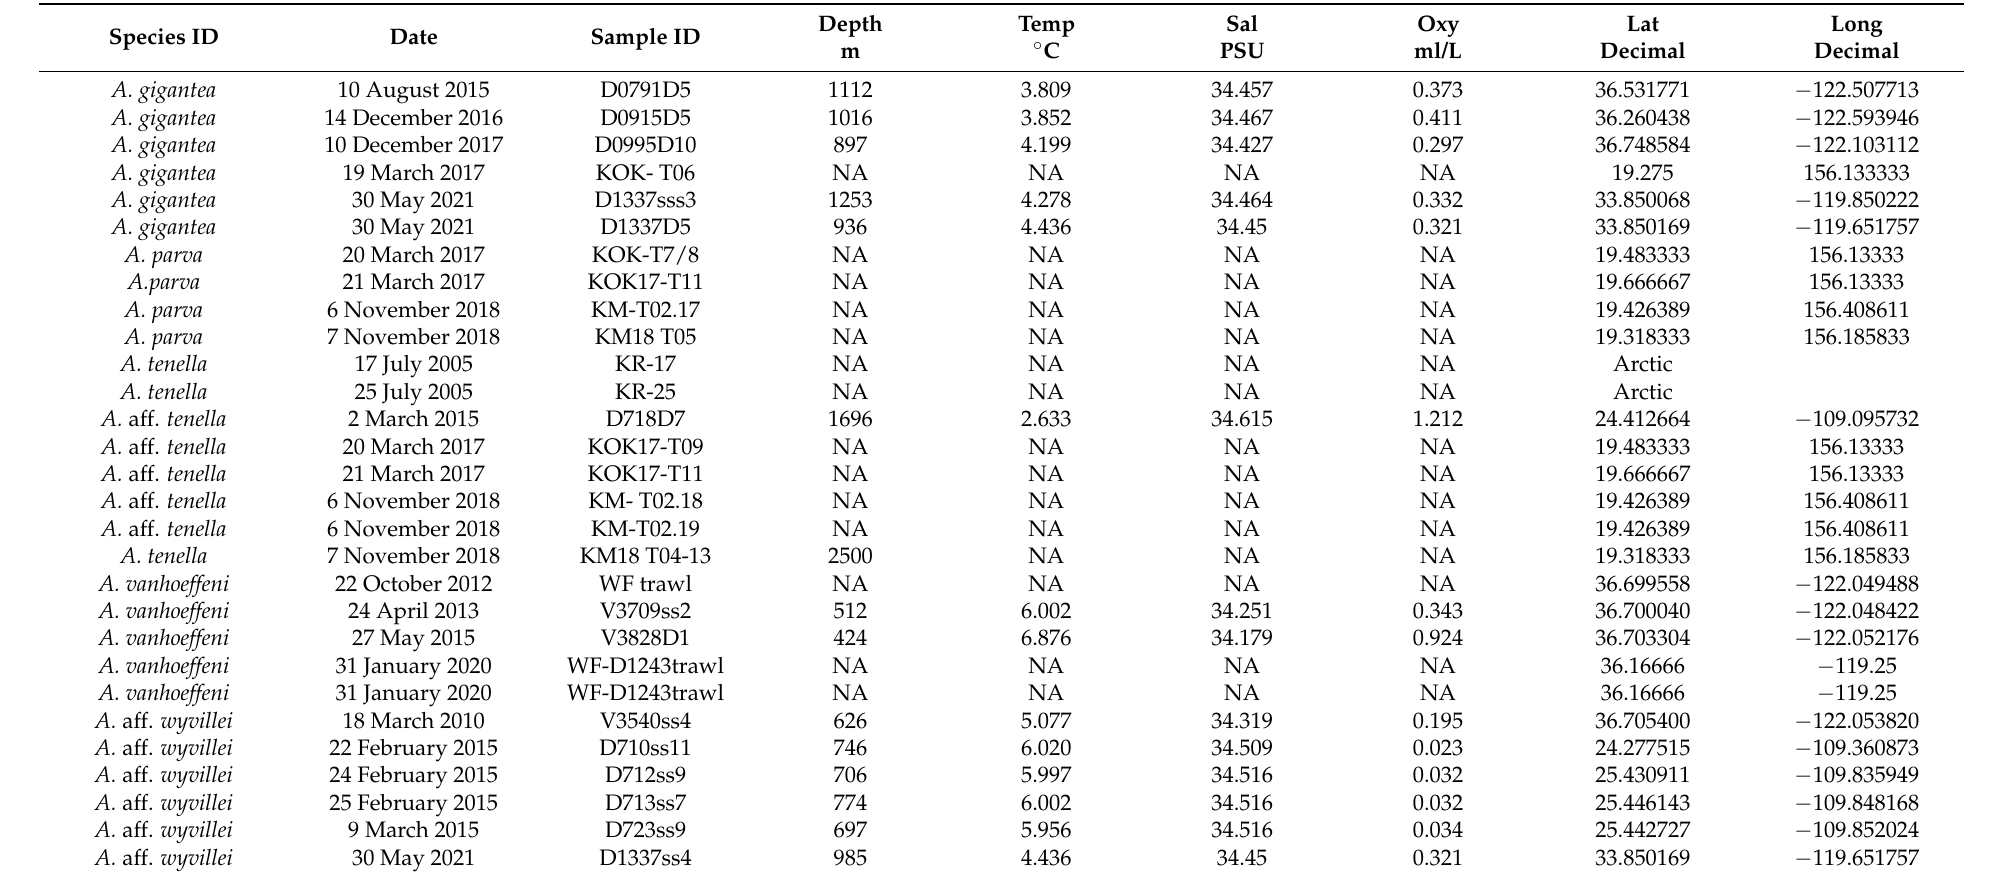
Table A1. Water parameters and collection information for sequenced Atolla and other coronate specimens. Sample ID refers to the remotely operated vehicle and the dive number (V for ROV Ventana , T for ROV Tiburon , or D for ROV Doc Ricketts ), blue-water SCUBA dive (BW) or trawls (T) aboard the RV Kilo Moana (KM), the RV Ka’imikai-O-Kanaloa (KOK), or the RV Western Flyer (WF). Two specimens of Atolla tenella collected in the Arctic were provided by Kevin Raskoff (KR). Some information was not available